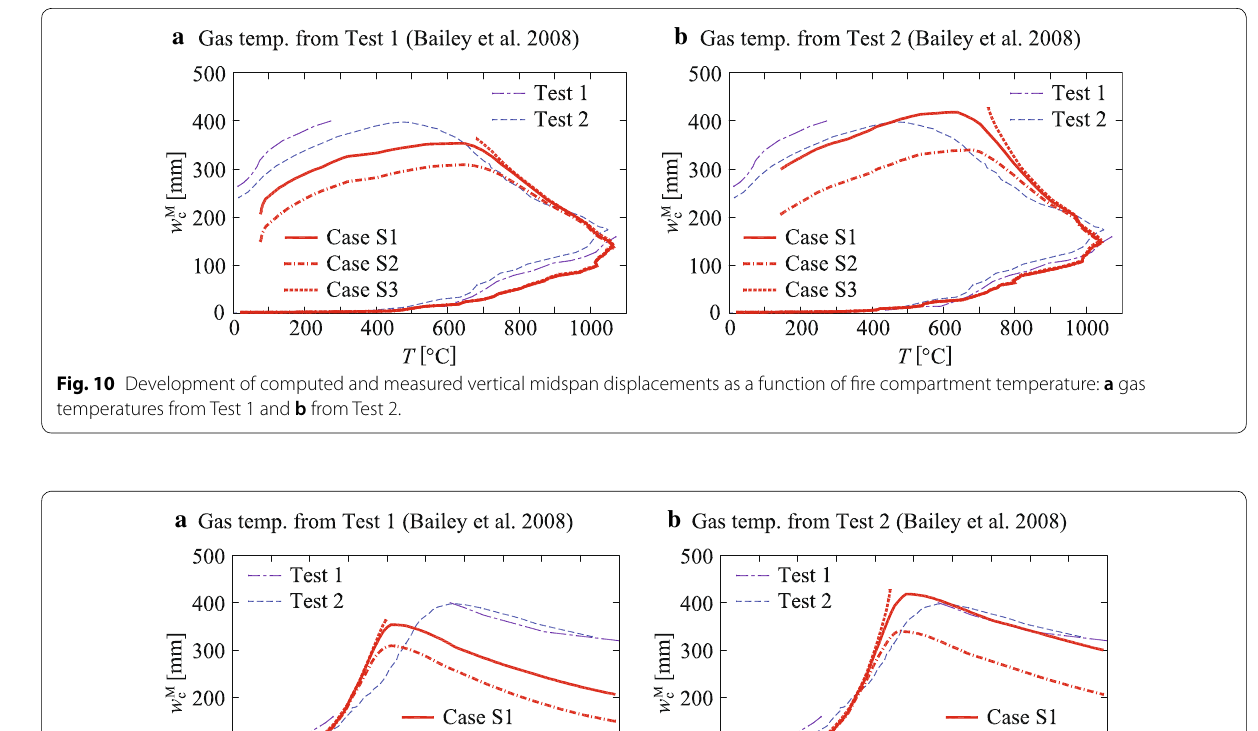
Fig. 11 Development of computed and measured vertical midspan displacements with time: a gas temperatures from Test 1 and b from Test